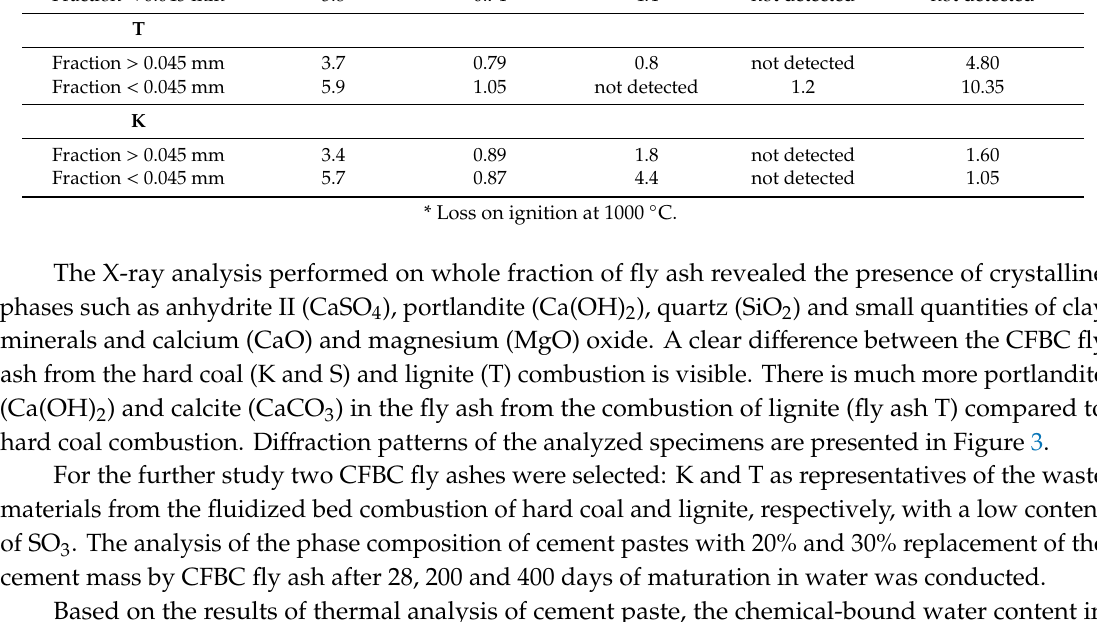
Mass Loss at Relics of Coal, < 350 ◦ C, wt % wt